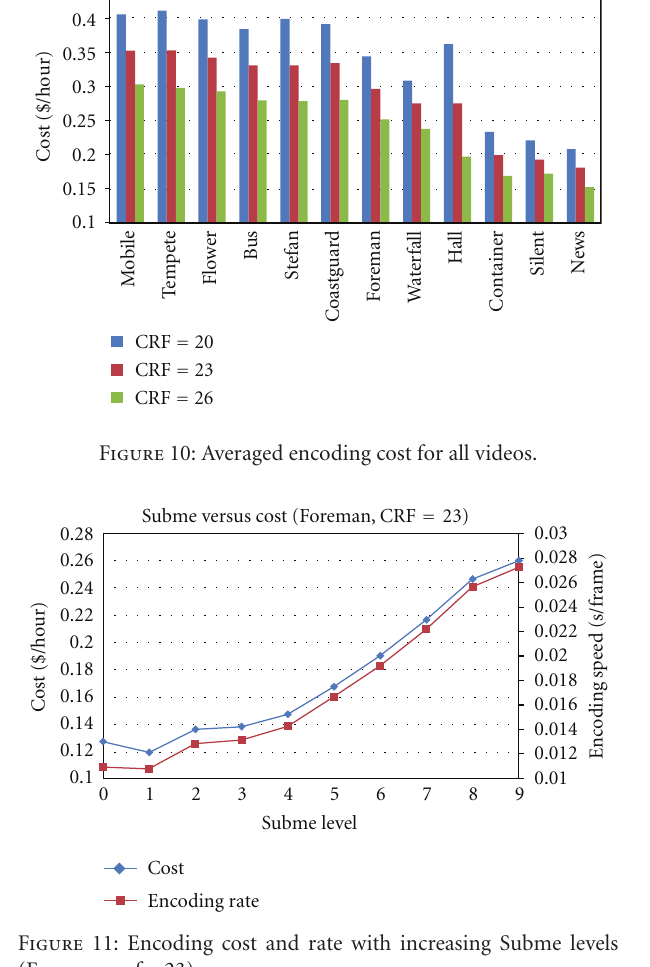
Figure 13: Encoding cost with increasing Subme levels under di ff erent CRF settings